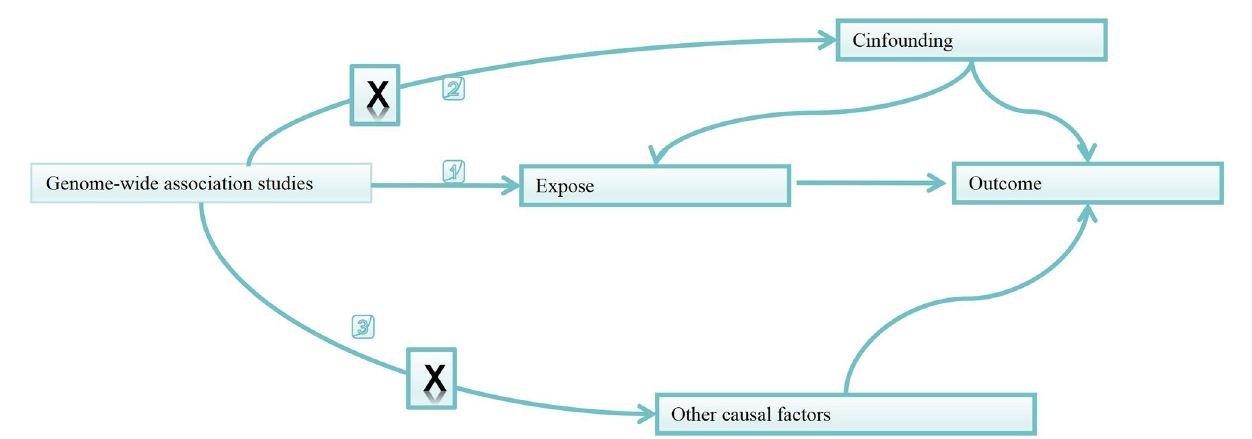
FIGURE 1 | Directed acyclic graphs for the classical Mendelian randomization designs. The arrows denote causal relations between two variables, pointing from the cause to the effect. The causal pathway is blocked if “X” is placed in the arrowed line. MR, Mendelian randomization.